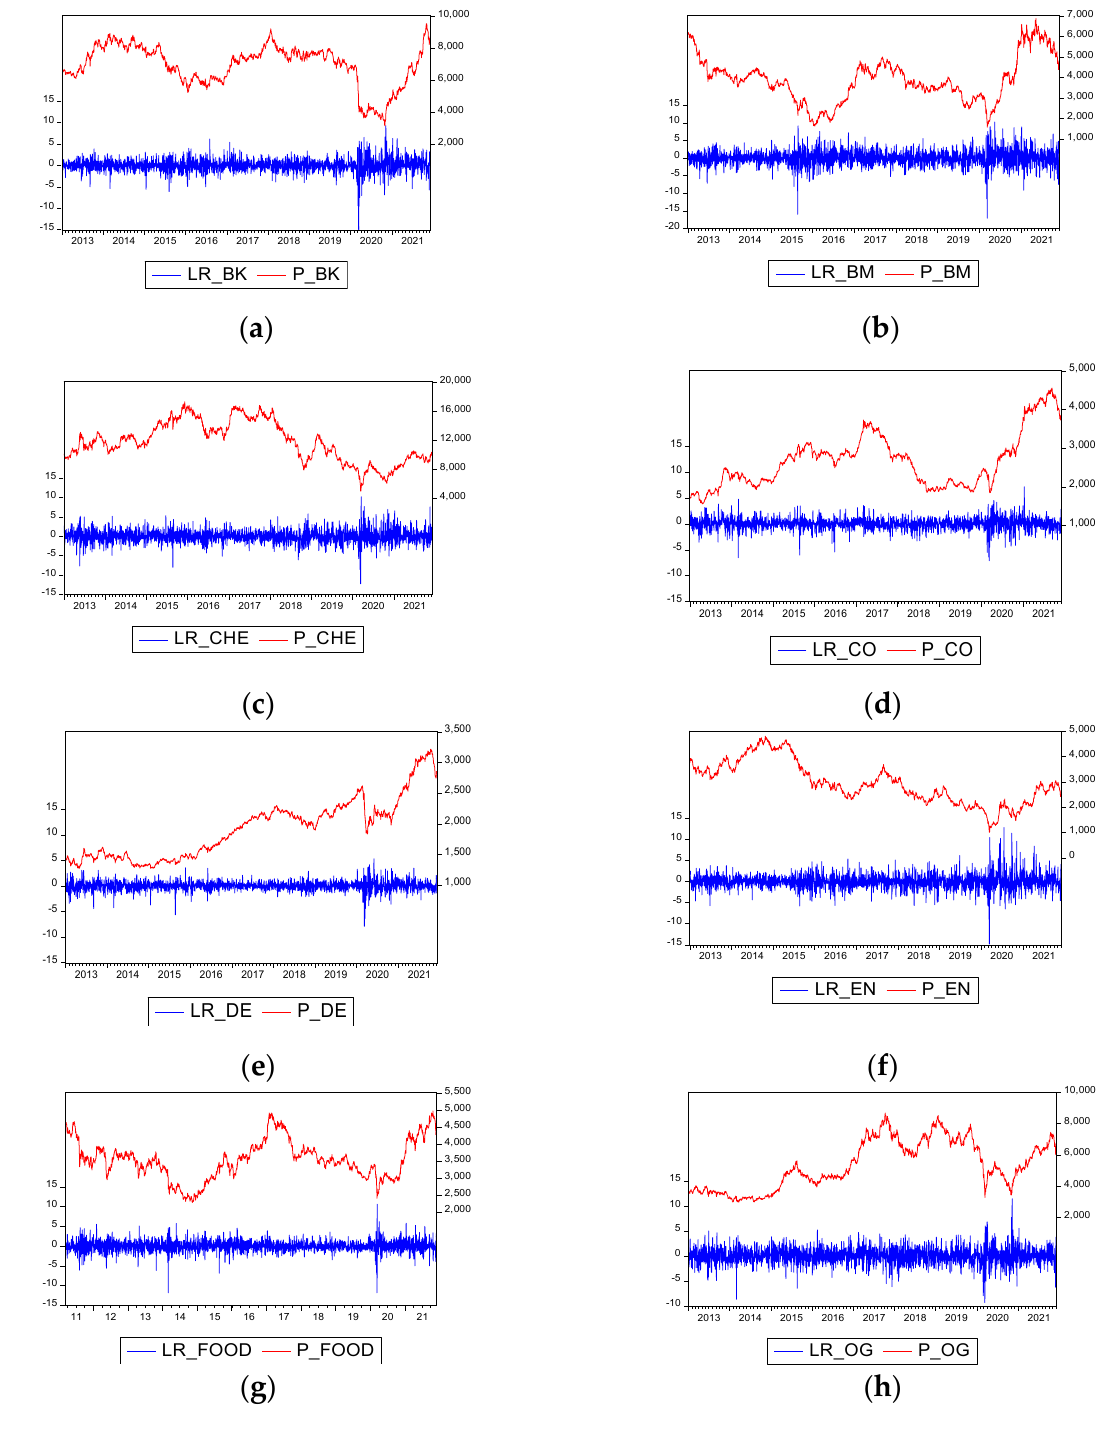
Figure 3. Return and volatility evolution of equity sectors on the Polish stock market from 1 January 2013 to 2 December 2021. Note: ( a ) LR_BK, P_BK ( b ) LR_BM, P_BM ( c ) LR_CHE, P_CHE ( d ) LR_CO, P_CO ( e ) LR_DE, P_DE ( f ) LR_EN, P_EN ( g ) LR_FOOD, P_FOOD ( h ) LR_OG, P_OG represent the returns as well as the values of the sectoral indices of banks, basic materials, chemicals, construction, developers, energy, food, and oil and gas, respectively.